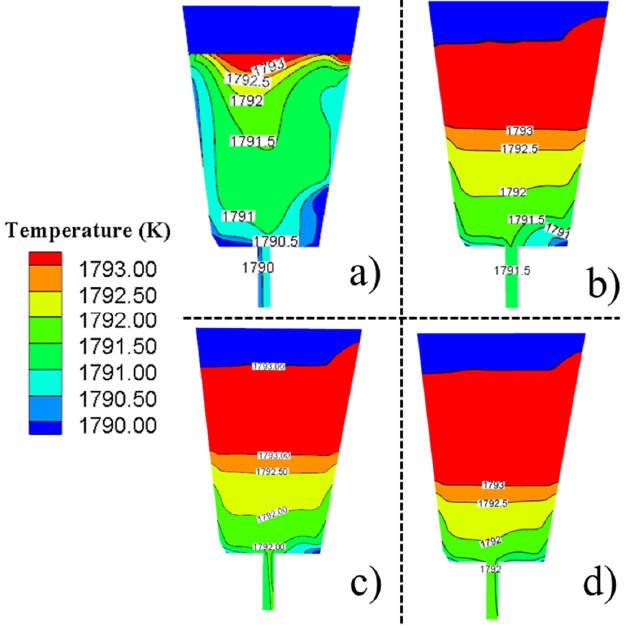
Figure 8. Temperature fields at plane 2 under different heating powers. ( a ) non plasma heating, ( b ) 300 kW, ( c ) 500 kW and ( d ) 1000 kW.